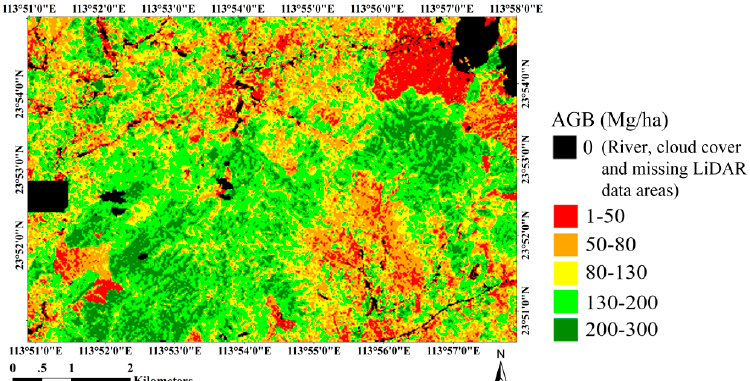
Figure 5. Spatial distributions of AGB estimated by the SSAE model with ACOLI1, AO and AL integrated variables. integrated